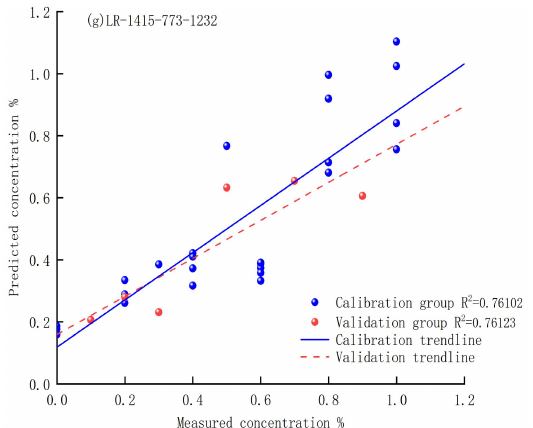
Figure 5. Scatter plot of measured-predicted values for SLR and MLR modelling of sample soluble salt